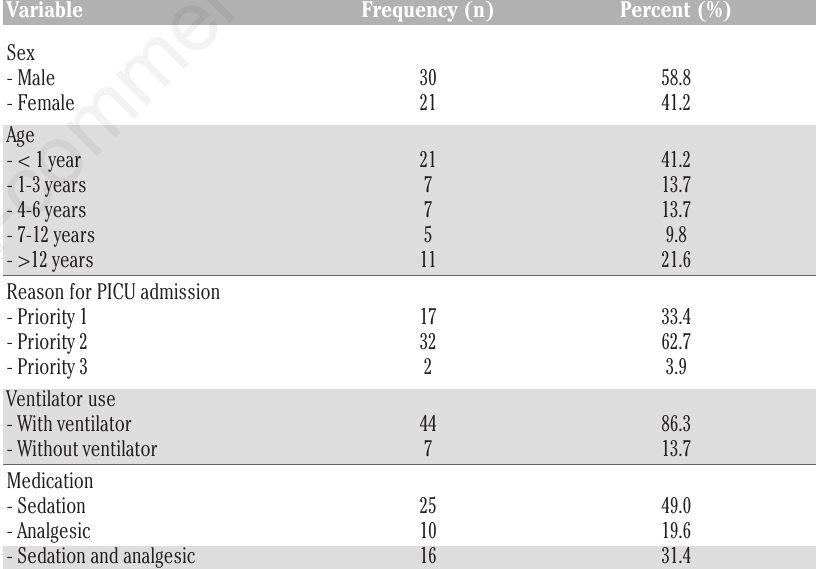
Table 1. Distribution of respondents’ characteristics (N= 51).